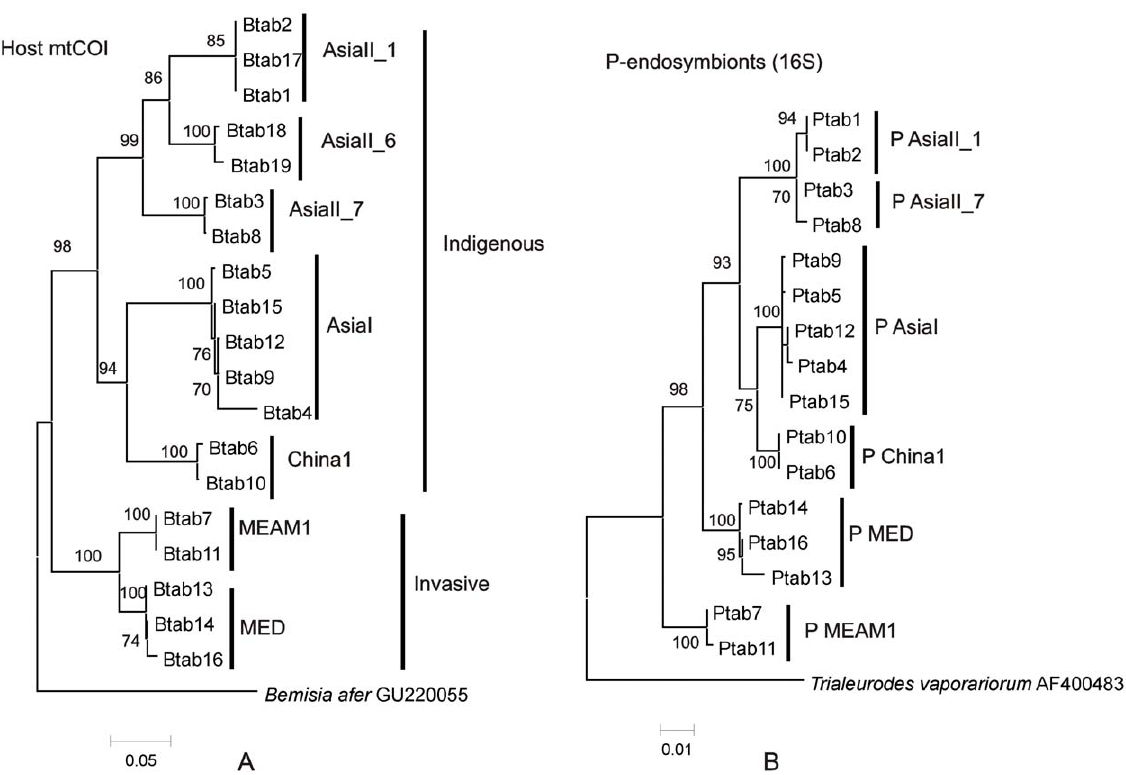
Figure 1. Phylogenies of the host B.tabaci cryptic species and their P-endosymbionts. A. Phylogenetic tree reconstruction based on mtCOI sequences (length=830 bp) of host B. tabaci cryptic species using ML analysis under the HKY + G substitution model. The bootstrap values are indicated. Bemisia afer (GU 220055) is used as outgroup. Accession numbers for Btab1-19 submitted to GenBank are JX428681–JX428696. All mtCOI sequences of host B. tabaci cryptic species used in this study were clustered with other blast references sequences from GenBank and their ML phylogenetic reconstruction is shown Fig. S1A. B. Phylogenetic tree reconstruction based on 16S rRNA gene sequences (length=1100 bp) of P- endosymbionts of B. tabaci cryptic species using ML analysis under the HKY + G substitution model. The bootstrap values are indicated. Trialeurodes vaporariorum (AF400483) is used as the outgroup. Accession numbers for Ptab1-Ptab16 submitted to GenBank are JX428713–JX428731. All 16S sequences of P-endosymbionts used in this study were clustered with other blast references sequences from GenBank and their ML phylogenetic reconstruction is shown Fig.. S1B.